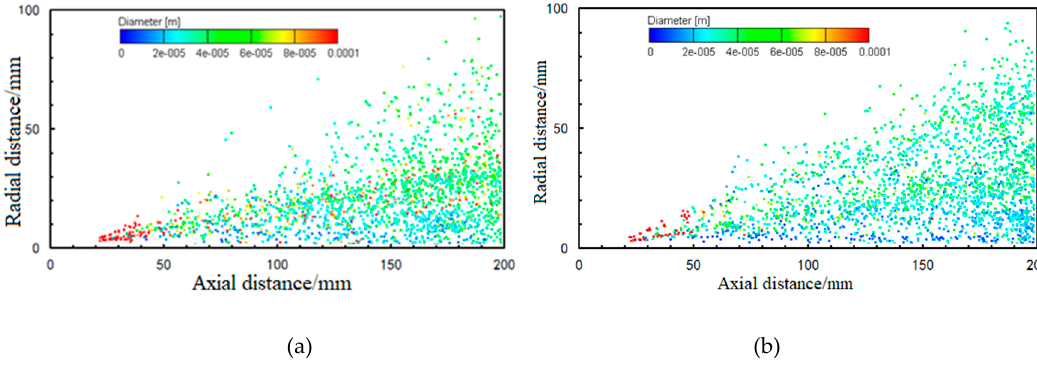
Figure 13. Simulation results of the spray particle size distribution with different nozzles. ( a ) Original Nozzle_3750 mL/h, SMD = 40.7 um; and ( b ) Optimized Nozzle_3750 mL/h, SMD = 37.1 um.